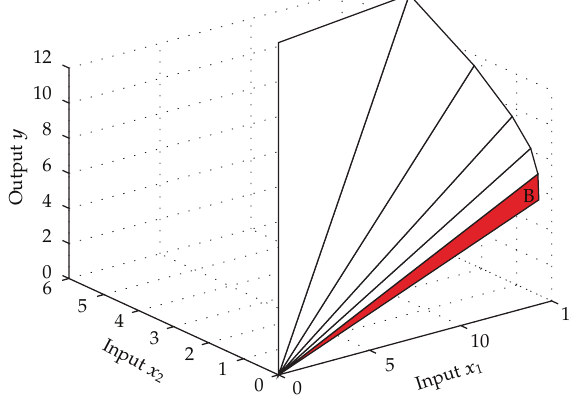
Figure 10: Scaled-up triangles, CRS.